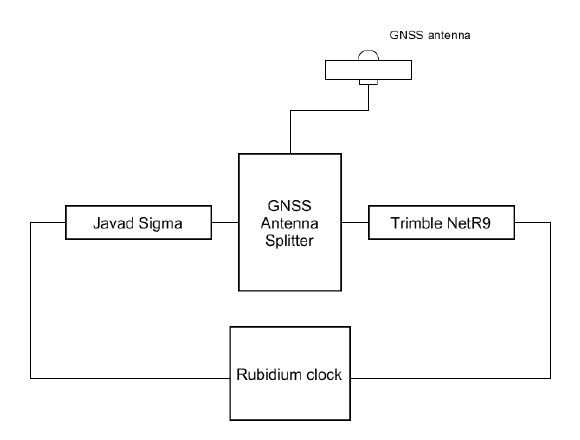
Figure 2: Zero-baseline setup at the secondary site in Mårtsbo